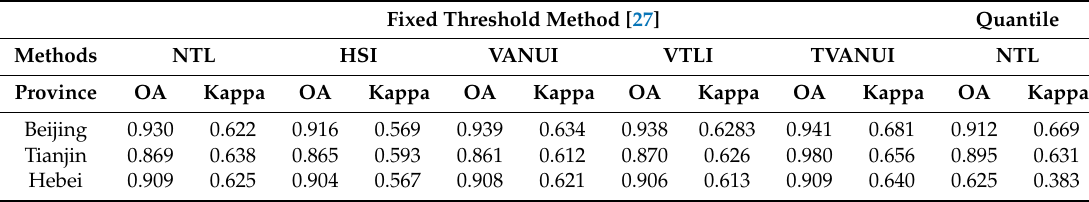
Table 5. Comparison with fixed threshold